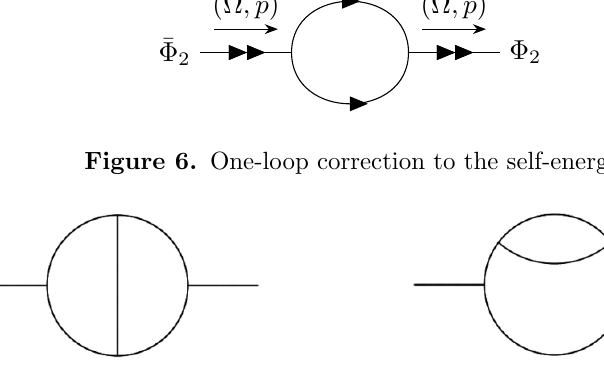
Figure 7. Topologies of possible two-loop corrections to the